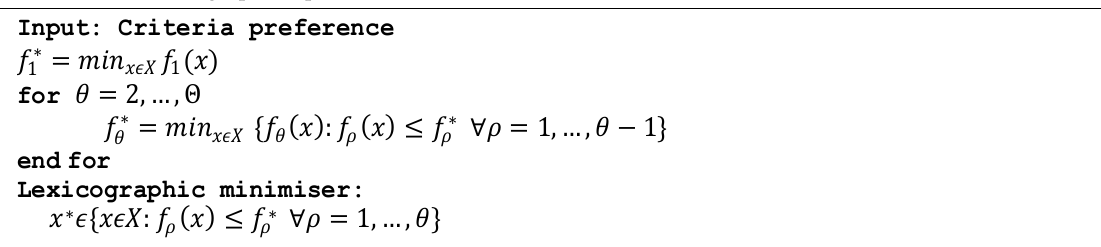
Algorithm 1 Lexicographic Optimisation